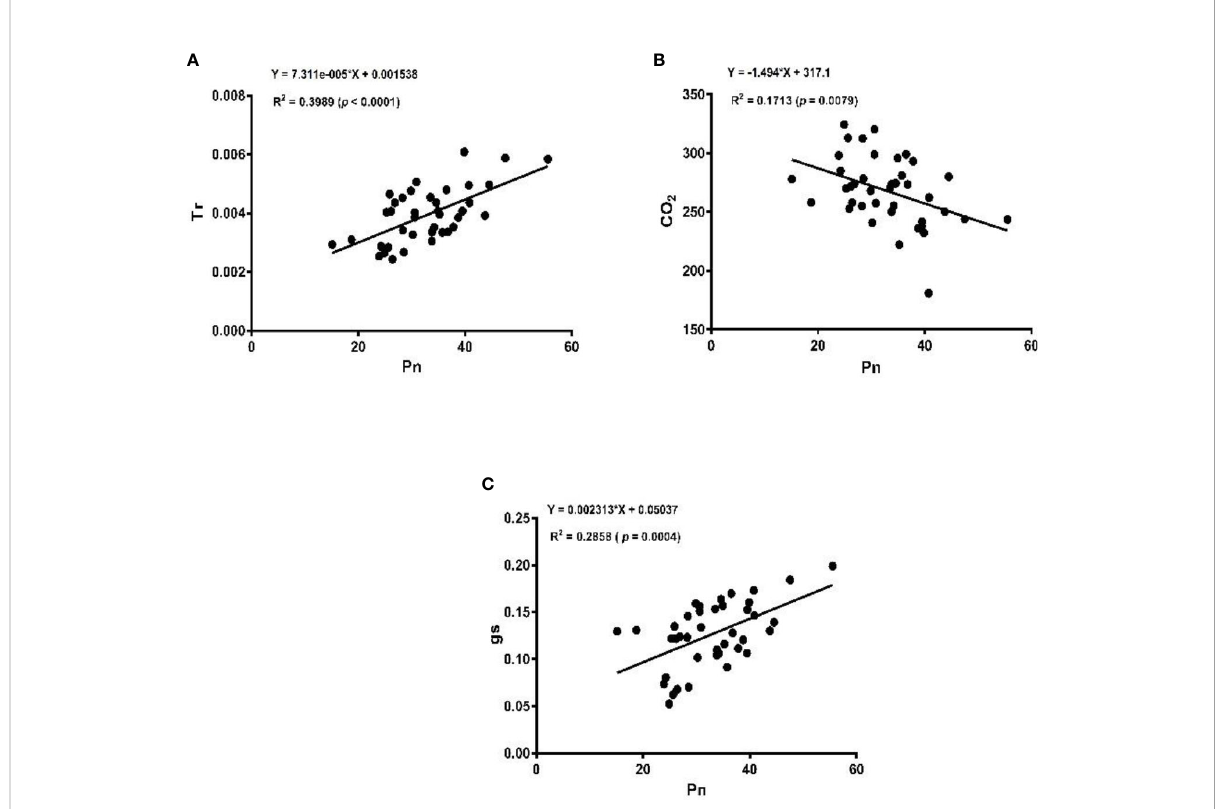
FIGURE 7 Linear regression of photosynthetic rate (Pn) with transpiration rate (Tr) (A) , intercellular carbon dioxide (CO 2 ) (B) , and stomatal conductance (gs) (C)